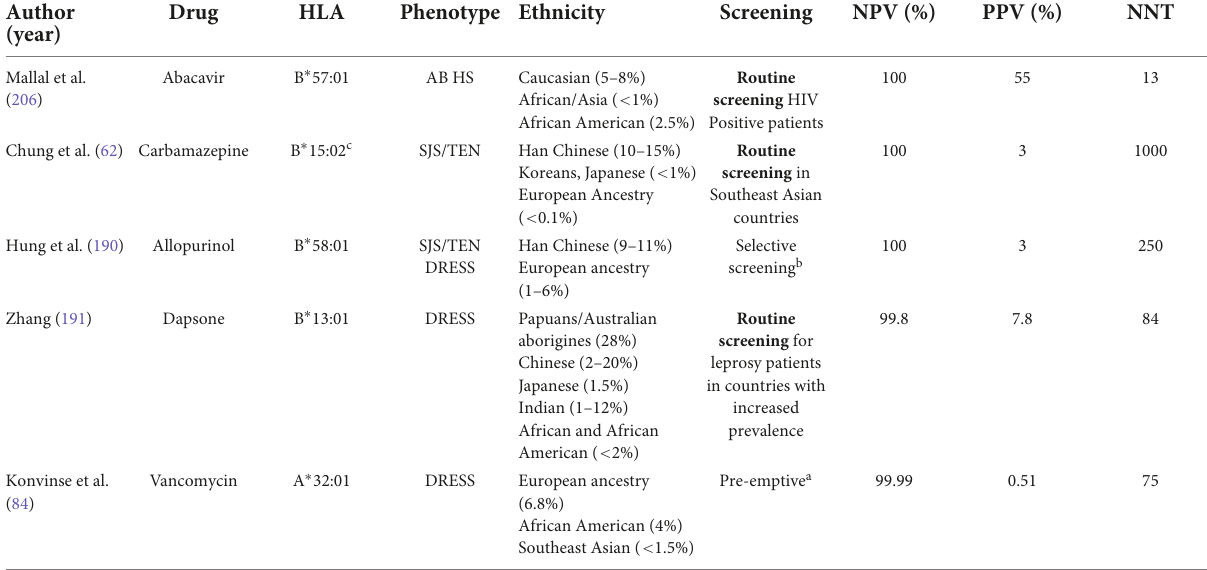
TABLE 6 Human leukocyte antigen (HLA) associations in delayed drug